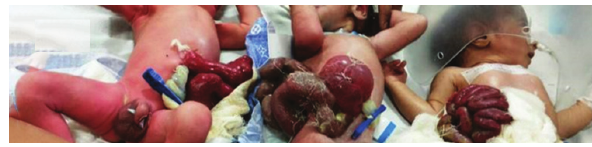
Figure 1: Three cases of a gastroschisis admission on a single